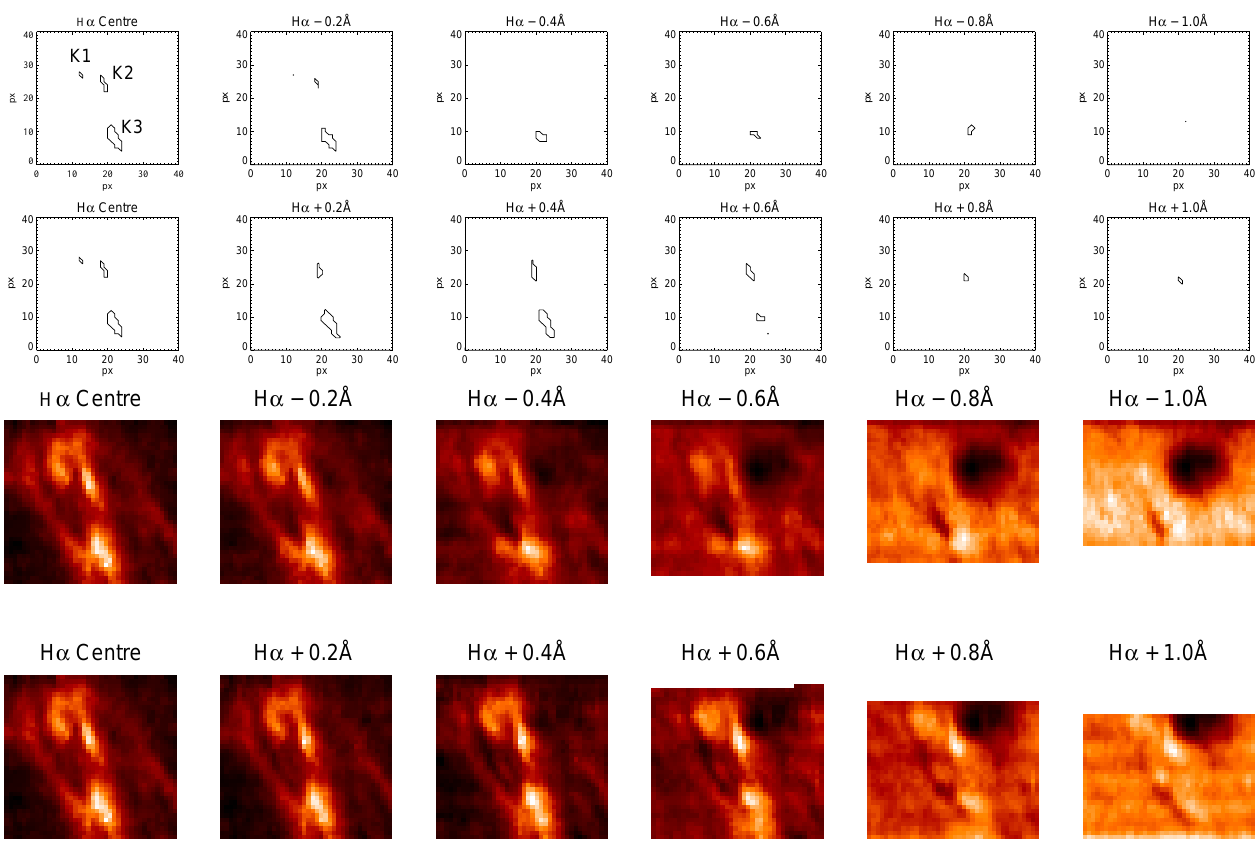
Fig. 1. C1.2 class solar flare observed in NOAA 10410 active region at 16:03:45UT on 16 July 2003. Upper panel: sizes and shapes of the flaring kernels K1, K2 and K3 delimited with isophote on the level of 75% of the net maximum brightness of the kernel. Lower panels: 2-D quasi-monochromatic images of the observed flaring kernels, obtained simultaneously in various wavelenghts. See main text for details.